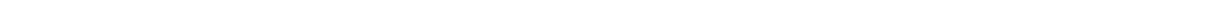
Fig. 2 Sequestering nuclear phosphoinositides suppresses ATR as well as ATRIP and ATR-mediated pChk1 recruitment. a Illustration of protein probes used for sequestering speci fi c nuclear PPIs. b Confocal montage of ATR recruitment upon laser microirradiation with or without the expression of individual cytosolic or NLS-tagged PPI-binding domains or their loss-of-function mutants. c Quanti fi cation of ATR recruitment within the ROI with the expression of cytosolic PLC δ -PH. d - f Quanti fi cation of ATR recruitment within the ROI with or without the expression of SidM-P4M, PLC δ -PH and Btk-PH domain, respectively, or their corresponding mutants. g Representative micrographs of control and PLC δ -PH-expressing cells stained with ATR and γ H2AX after laser microirradiation and h the corresponding quanti fi cation of fl uorescence signals within the ROI. i, j Representative micrographs of similar experiments stained for ATRIP and its corresponding quanti fi cation. k , l Another similar experiment stained for pChk1-S345 and its corresponding quanti fi cation. Dashed circles are 2.5 μ m in diameter indicating the ROI for laser microirradiation. Data are representative of three independent experiments. Error bars represent mean ± s.e.m. Student ’ s t -test, *** p < 0.001; **** p < 0.0001. n.s. represents not signi fi